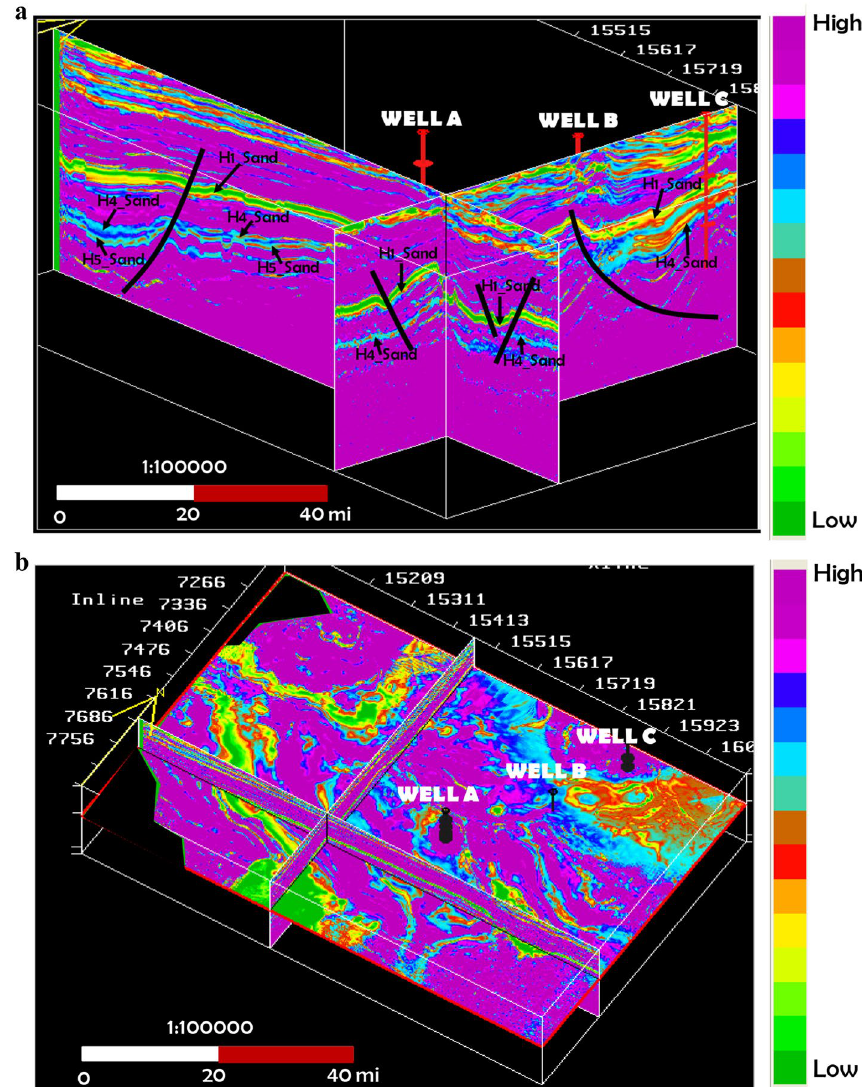
Fig. 10 a An interception (inline and crossline) section showing the distribution of faults and H-sands in the field. Note: low values of lithology impedance correspond to good- quality hydrocarbon sand. b A map (with inline and crossline) section at 2650 ms showing the hydrocarbon-filled channel sand in the northeast–southwest direction. Note: low values of Poisson impedance correspond to good-quality hydrocarbon